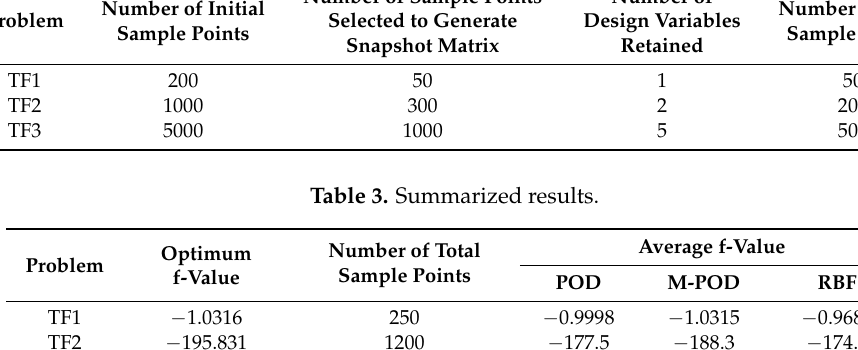
Table 2. Parameter settings of M-POD (POD coupling with adaptive sampling method).